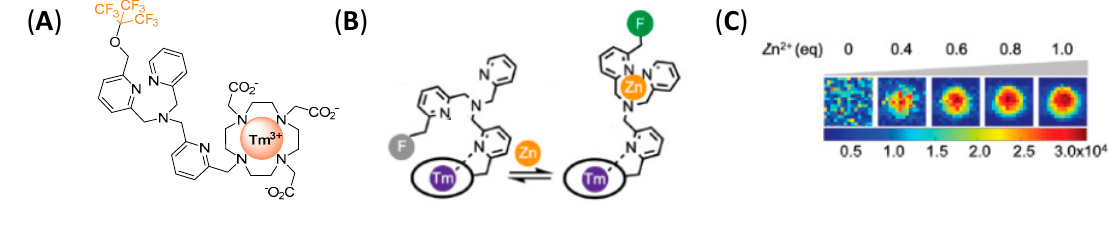
Figure 11. ( A ) Chemical structure of TmPFZ-1 ; ( B ) Schematic representation of the conformational exchange within TmPFZ-1 upon Zn 2+ complexation; ( C ) 19 F MRI images of TmPFZ-1 (4 mM) in the presence of different Zn 2+ equivalents. Adapted with permission from Ref [81]; published by The Royal Society of Chemistry, 2020.